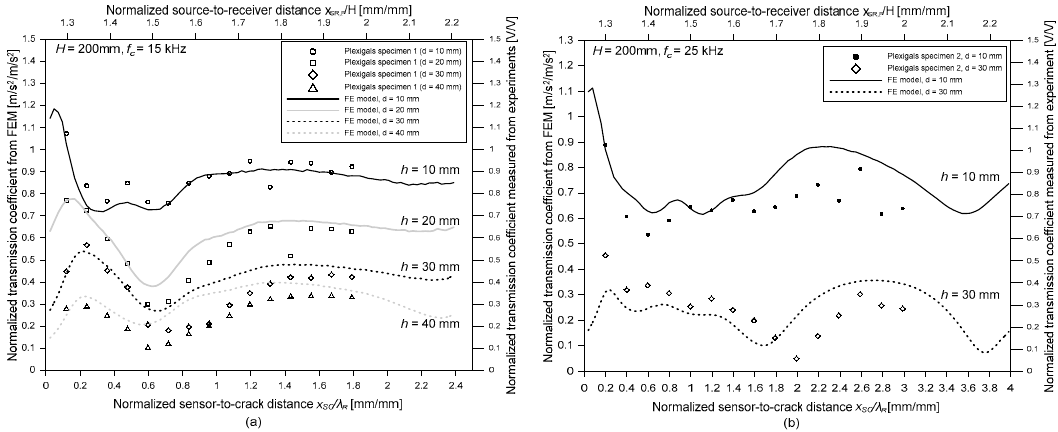
Figure 8. Variation of normalized transmission coefficient of surface waves, Tr n , in plate with the thickness of 200 mm with respect to two relative sensor locations (normalized source-to-receiver distance, x SR /H and normalized receiver-to-crack distance, x RC / λ R ) at two frequencies: ( a ) f c = 15 kHz and ( b ) f c = 25 kHz. For comparison, experimental results measured on Plexiglas specimens with various crack depths are shown in the figure.